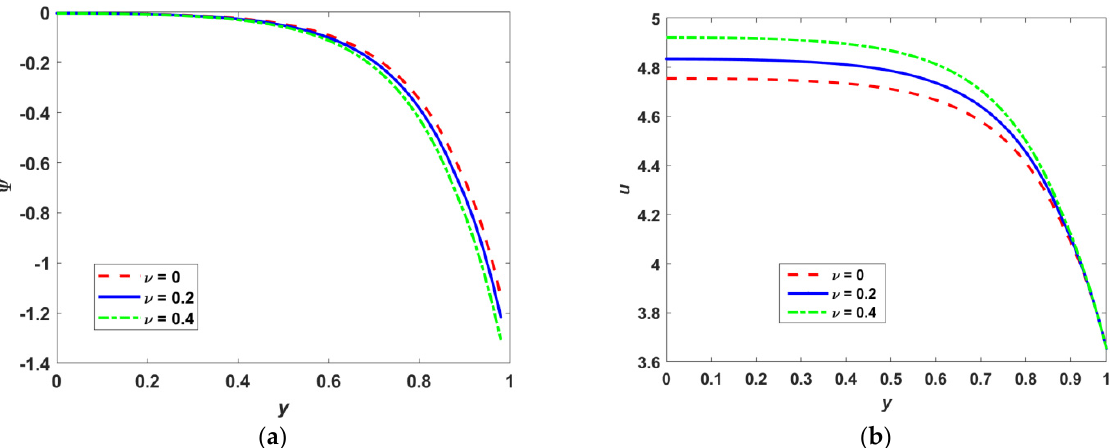
Figure 3. The distributions of ( a ) dimensionless electrical potential ψ ( y ) and ( b ) dimensionless flow velocity u ( y ) for the different steric factors ( ν = 0, 0.2, 0.4) when λ = 0.15, λ FCL = 0.5, α = 1, γ = 0.5 and Ω = 8 .